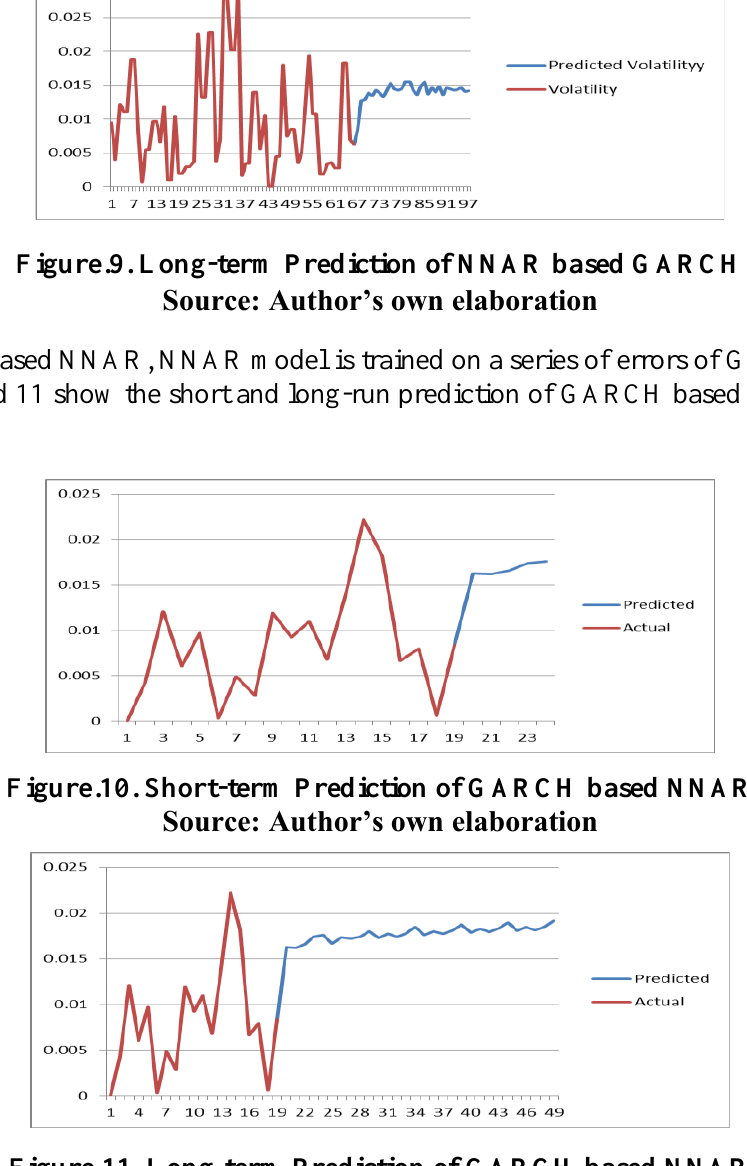
Table.3. Result of Hybrid Model (Linear Combination of GARCH and